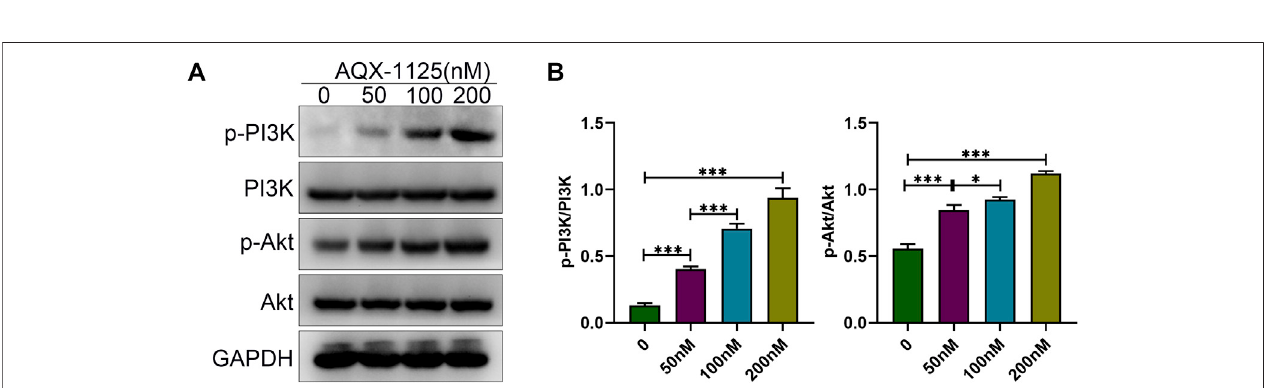
FIGURE3| formationassayofosteoclastsandquanti fi cationofthepitsarea.Theimageswerecapturedwithamicroscope.Scalebars=100 μ m.Dataarepresentedas means ± SD from three independent experiments (* p < 0.05; ** p < 0.01; *** p < 0.001).